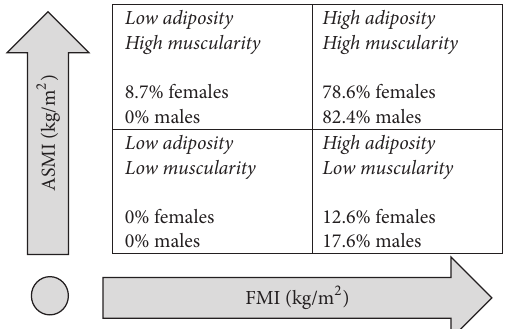
Figure 3: Body composition phenotype, by decile groups of appen- dicular skeletal mass index (ASMI) and fat mass index (FMI), for adults with class II/III obesity ( 𝑛 = 120 , females = 103)